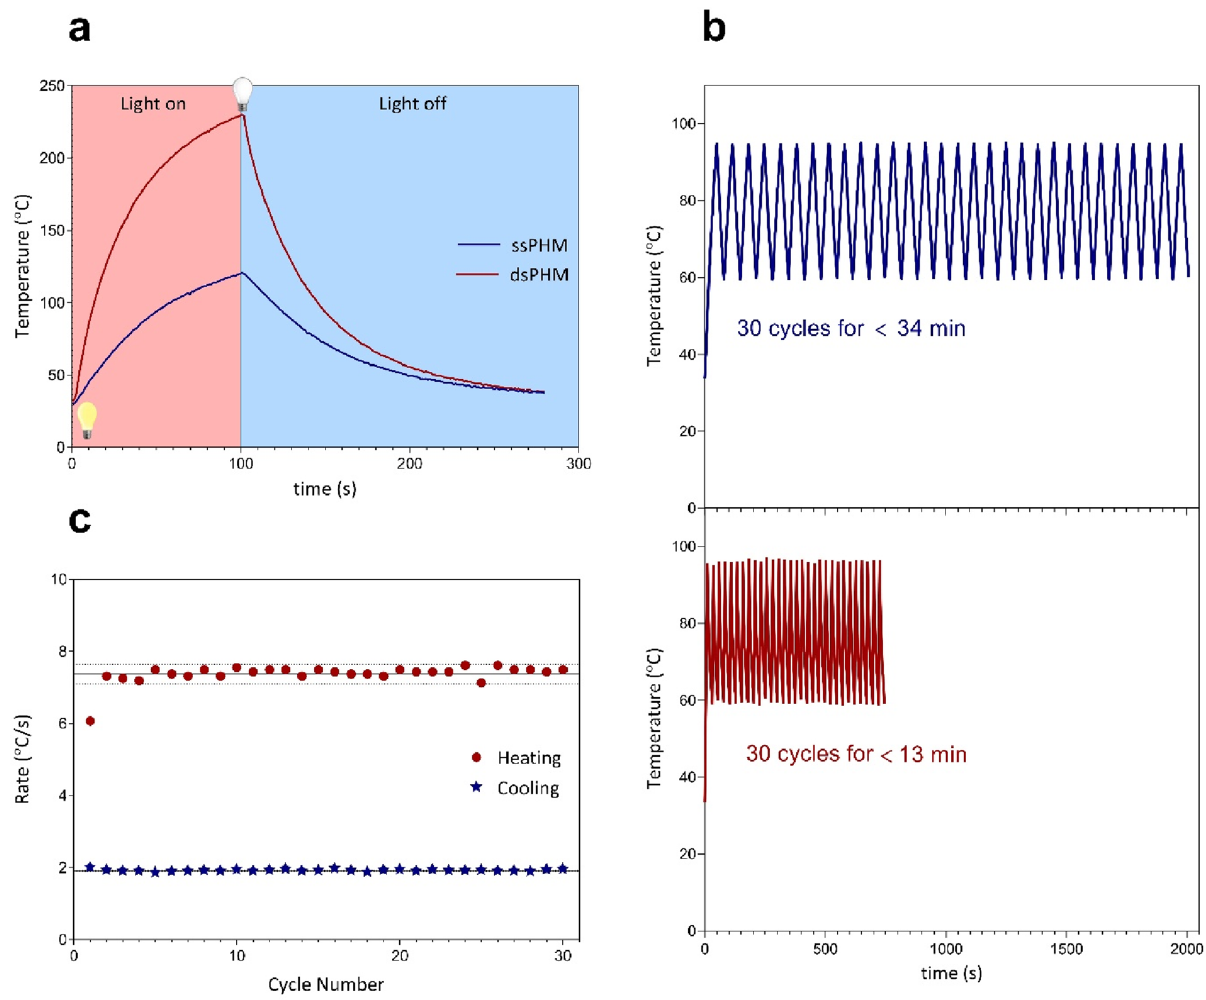
Figure 5. ( a ) Temperature profiles of the single-sided plasmonic heating mechanism (ssPHM) and the dual- sided plasmonic heating mechanism (dsPHM) for the blue light. ( b ) Temperature profiles of the sample in the ssPHM and the dsPHM for denaturation-to-annealing ramp and vice versa (30 PCR thermal cycles, 95 °C for 0 s and 60 °C for 1 s). ( c ) Heating and cooling rates obtained from the dsPHM thermal cycling (average heating and cooling rates of 7.37 ± 0.27 °C/s and 1.91 ± 0.03 °C/s, respectively). Solid lines indicate average values. Dashed lines are placed one standard deviation away from Rapid droplet‑based PCR amplification and end‑point fluorescence detection. To evaluate the functionality of our rapid dpPCR system, a positive control reaction containing the AOX gene as a tem- plate and a no template control reaction were performed. To eliminate the need for gel electrophoresis or other post-amplification processes, EvaGreen dye-based Master Mix was used. End-point fluorescence detection was achieved using an inverted fluorescence microscope. Fluorescence images of the positive and negative reactions are shown in Fig. 7a,b. The green fluorescence image of the droplets in the positive control reveals that the target DNA was successfully amplified using our rapid photonic PCR system. No positive signal and no contamination were observed when negative control was conducted using sterile double-distilled water instead of the template. As shown in Fig. 7c, the average fluorescence intensity of the positive droplets was normalized to that of the NTC droplets. The average green pixel intensity of the positive droplets (right) was significantly higher (approximately 5 times) than that of the NTC ones (left). As mentioned previously, a 325 bp DNA fragment was chosen as the target sequence. It should be noted that the performance of such droplet-based assays is detrimentally affected if longer amplicon lengths are designated 59 . In this regard, Fig. S4 shows the significant decrease in the fluorescent intensity of positive control droplets when appropriate PCR reagents with comparable template concentration are used to amplify a DNA fragment of length 1800 bp. The successful application of EvaGreen intercalating dye in droplet-based PCR relies on the specific amplifica- tion of DNA targets. Typically, EvaGreen can bind to double-stranded DNA (dsDNA) and single-stranded primer sequences; therefore, primer-dimer or other nonspecific DNA fragments can contribute to the fluorescence emis- sion of negative droplets. To verify the amplification of the correct product, a PCR melting curve analysis was performed by the Mic qPCR cycler. As it can be found in Fig. S5, a single peak at 86.05 °C was observed for the